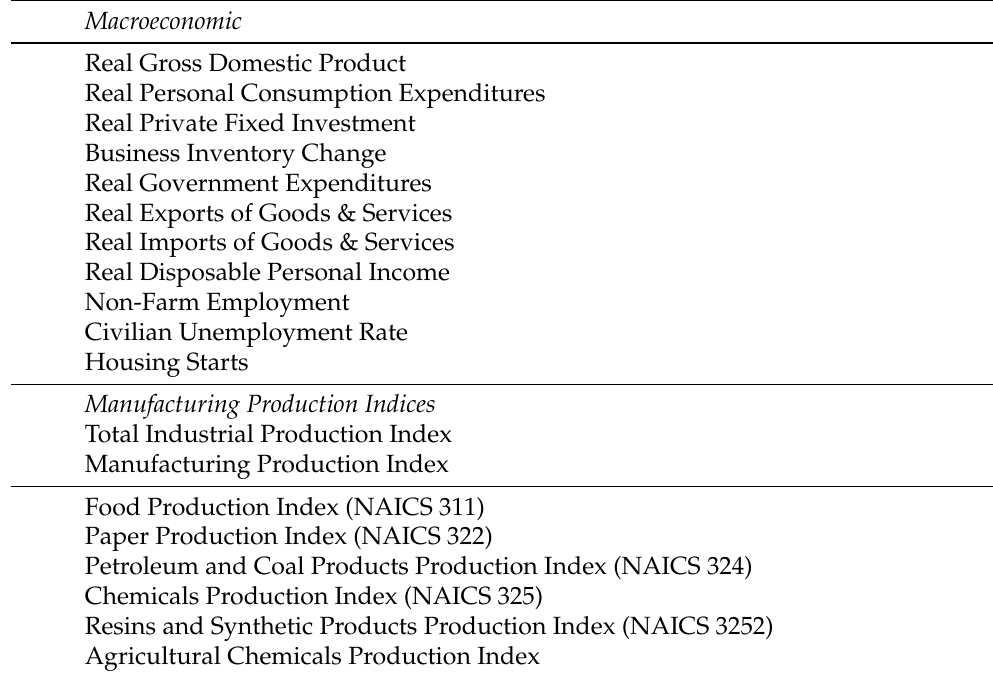
Table 1. U.S. EIA database on Macroeconomic indicators and CO 2